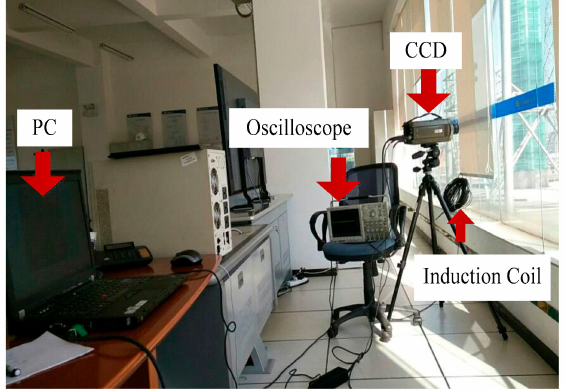
Figure 2. The system of discharge image capture.